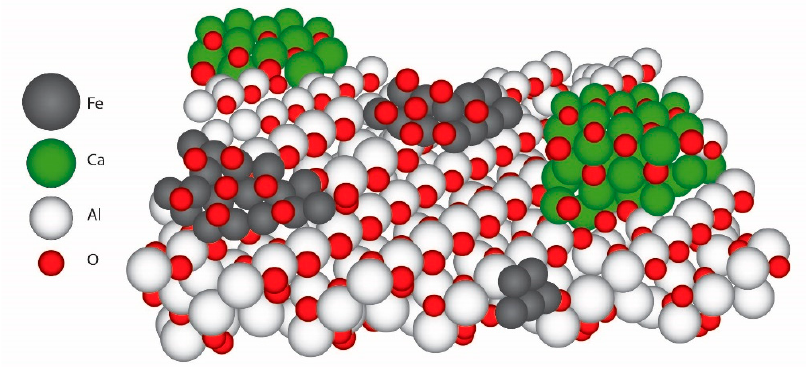
Figure 1. Schematic description of the eco-friendly, fluidizable Fe x O y / CaO / γ -Al 2 O 3 catalyst and its constitutive elements. Notes: black dots refer to Fe, white dots to Al, green dots to calcium, red dots to